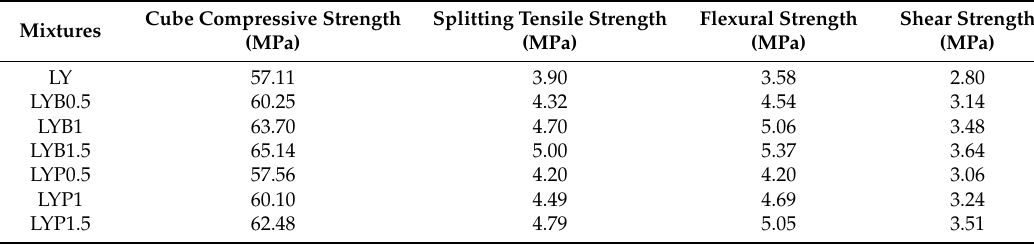
Table A1. Average value of strengths by